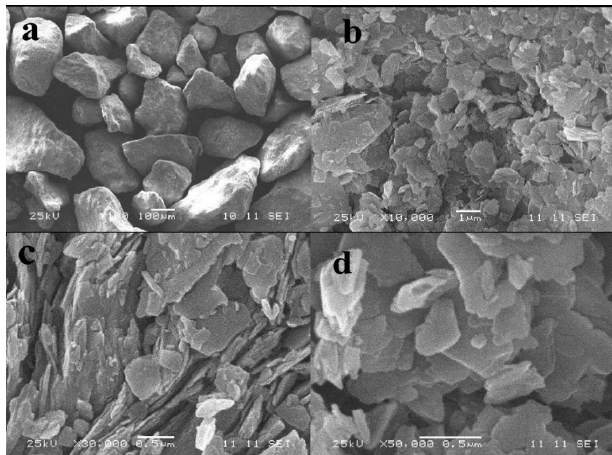
Figure 9. SEM images of porous silica prepared via acid leaching of kaolinite activated at 850 °C for 15 min. ( a ) × 100; ( b ) × 10,000; ( c ) × 30,000; ( b ) × 50,000.